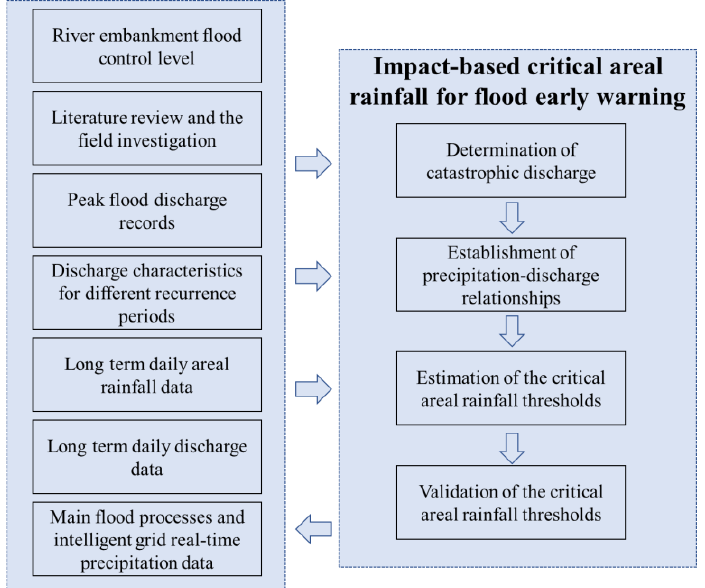
Figure 2. The methodological framework performed in this